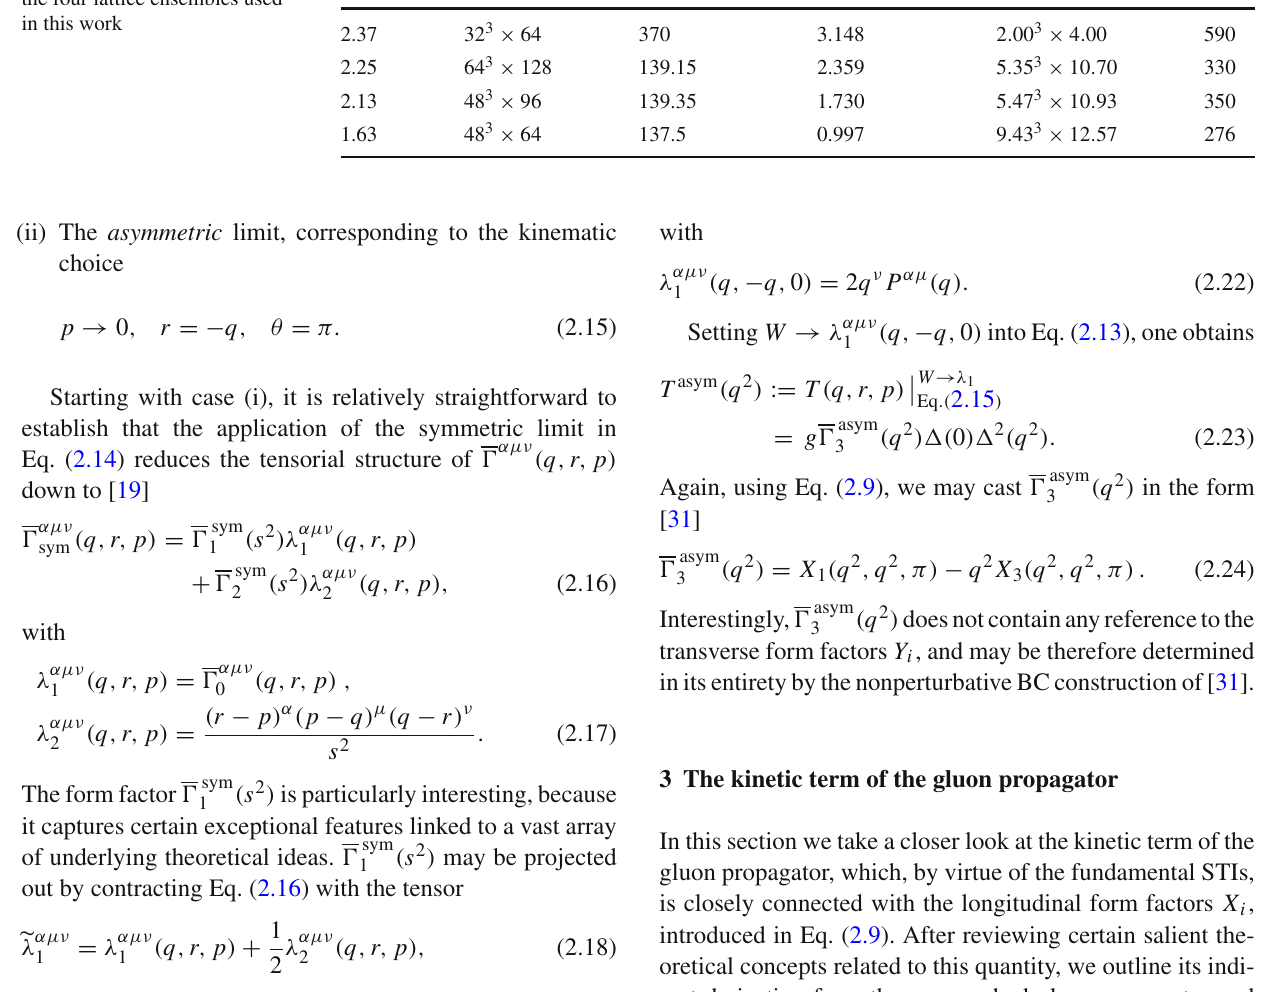
Table 1 Setup parameters